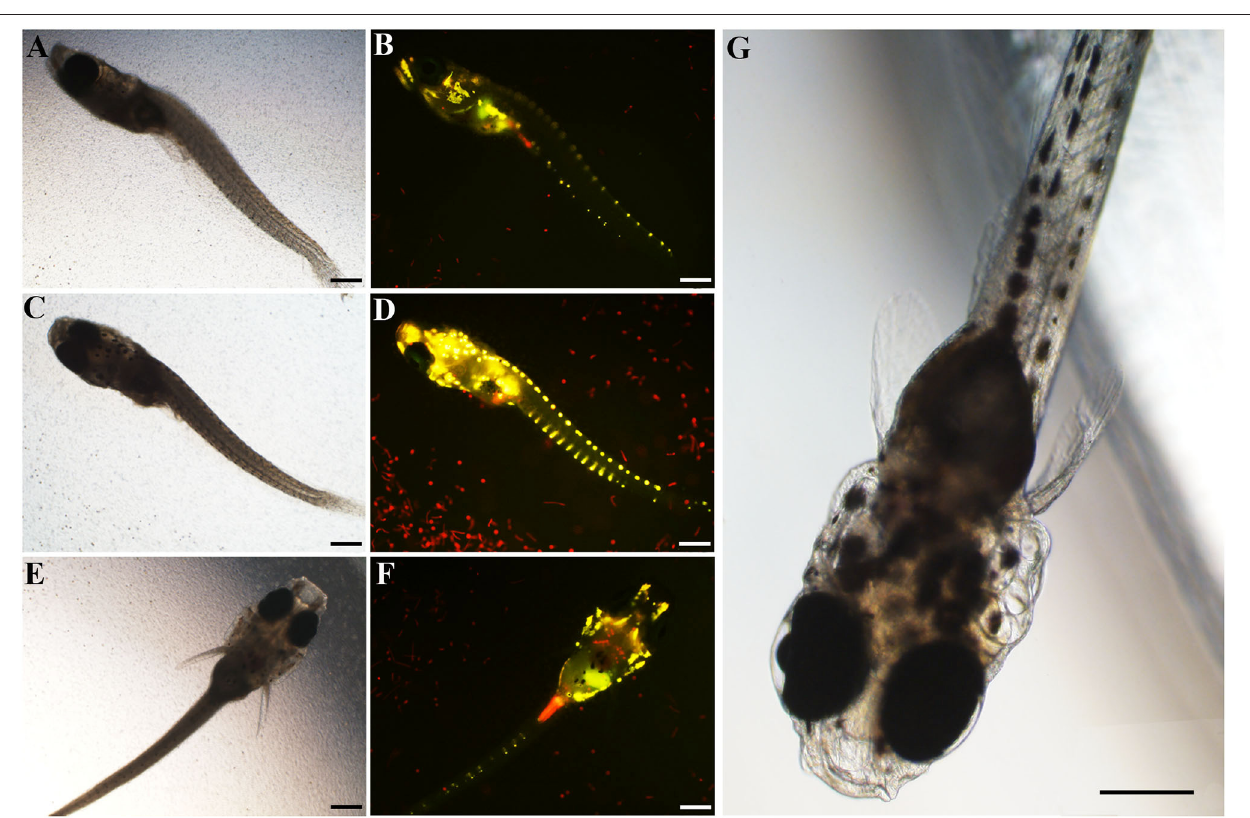
No. of fish dead No. of fish dead Average death time within 24 h within 48 h within 96 h (h) within 24 h